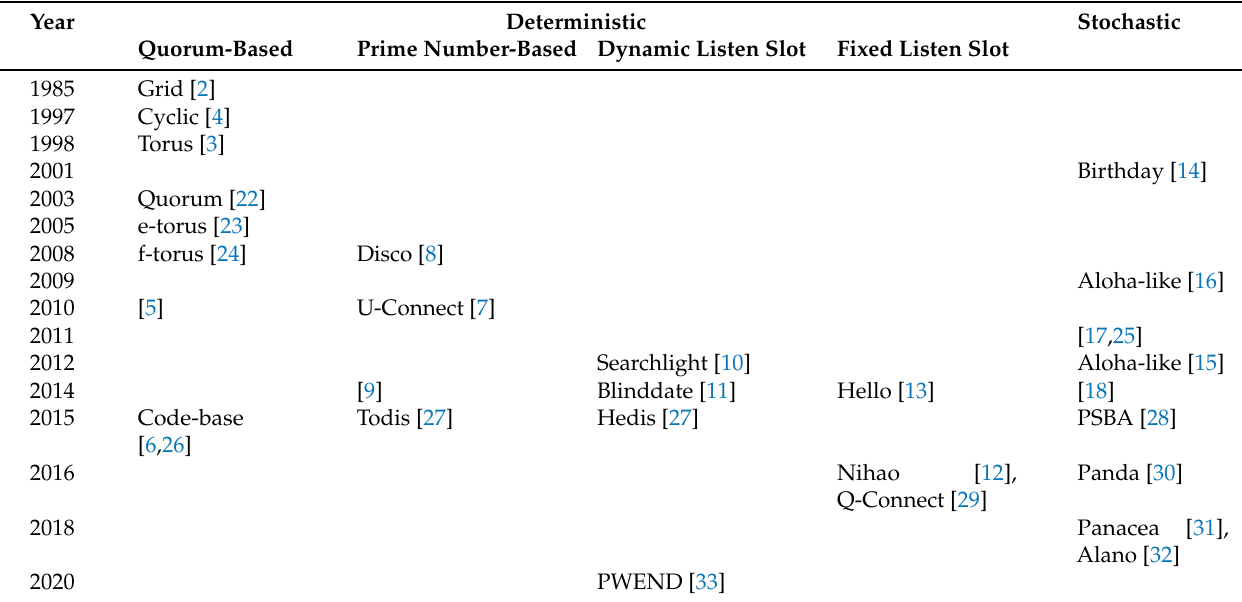
Table 1. Summary of the most significant ND protocols in the